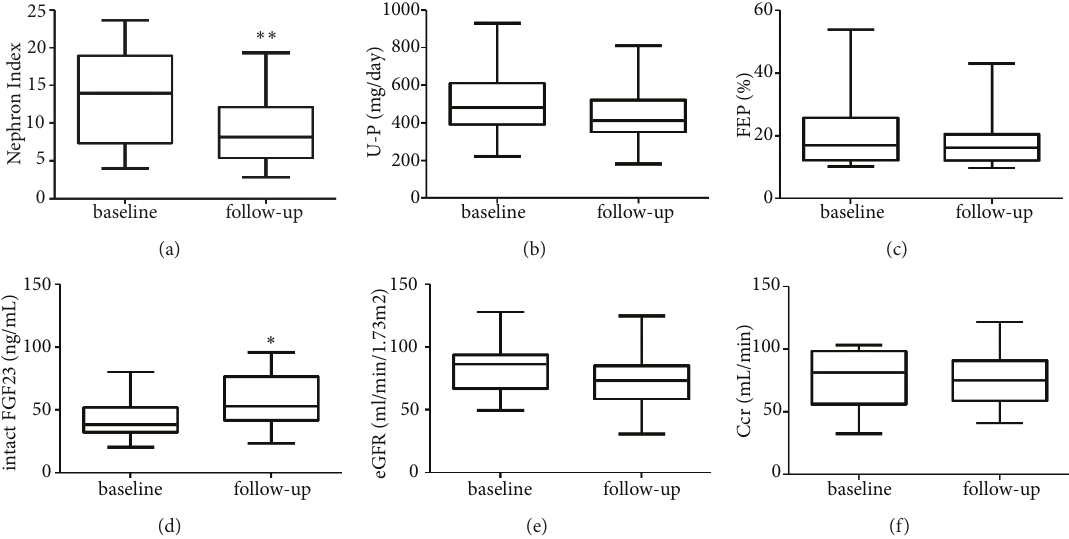
Figure 1: Comparisons of nephron index (a), daily (24 h) urinary phosphate excretion (U-P) (b), fractional excretion of phosphate (FEP) (c), serum intact FGF23 (d), estimated glomerular filtration rate (eGFR) (e), and creatinine clearance (Ccr) (f) between baseline and time after follow-up in the patients with type 2 diabetes. ∗ p < 0.05 vs. baseline, ∗∗ p < 0.01 vs.